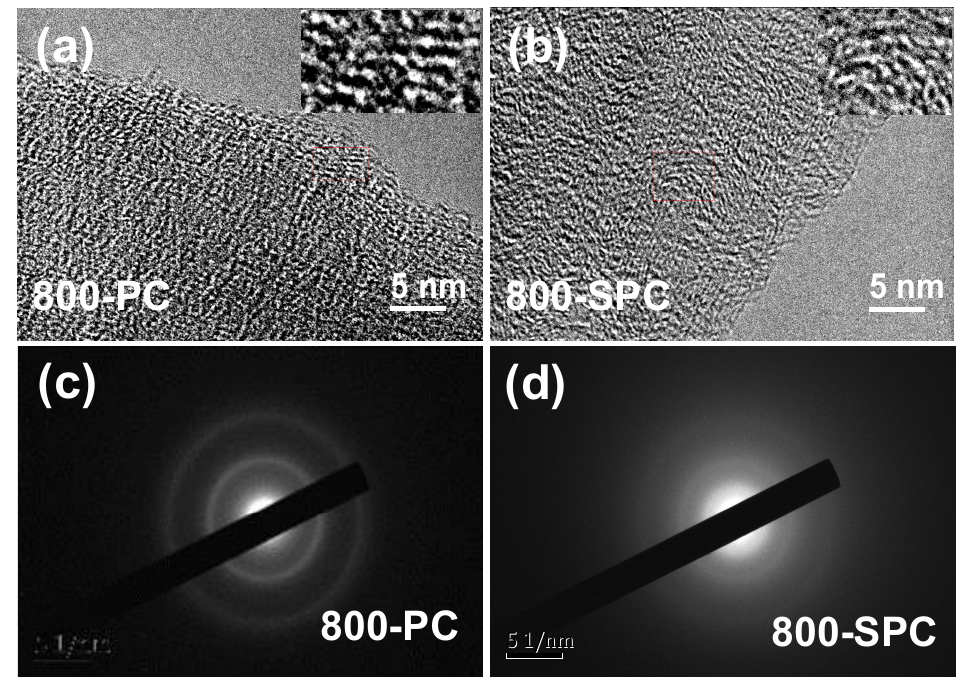
Figure 5. TEM images of PC ( a ) and SPC ( b ) materials. Selected area electron diffraction (SAED) patterns of PC ( c ) and SPC ( d ) materials.